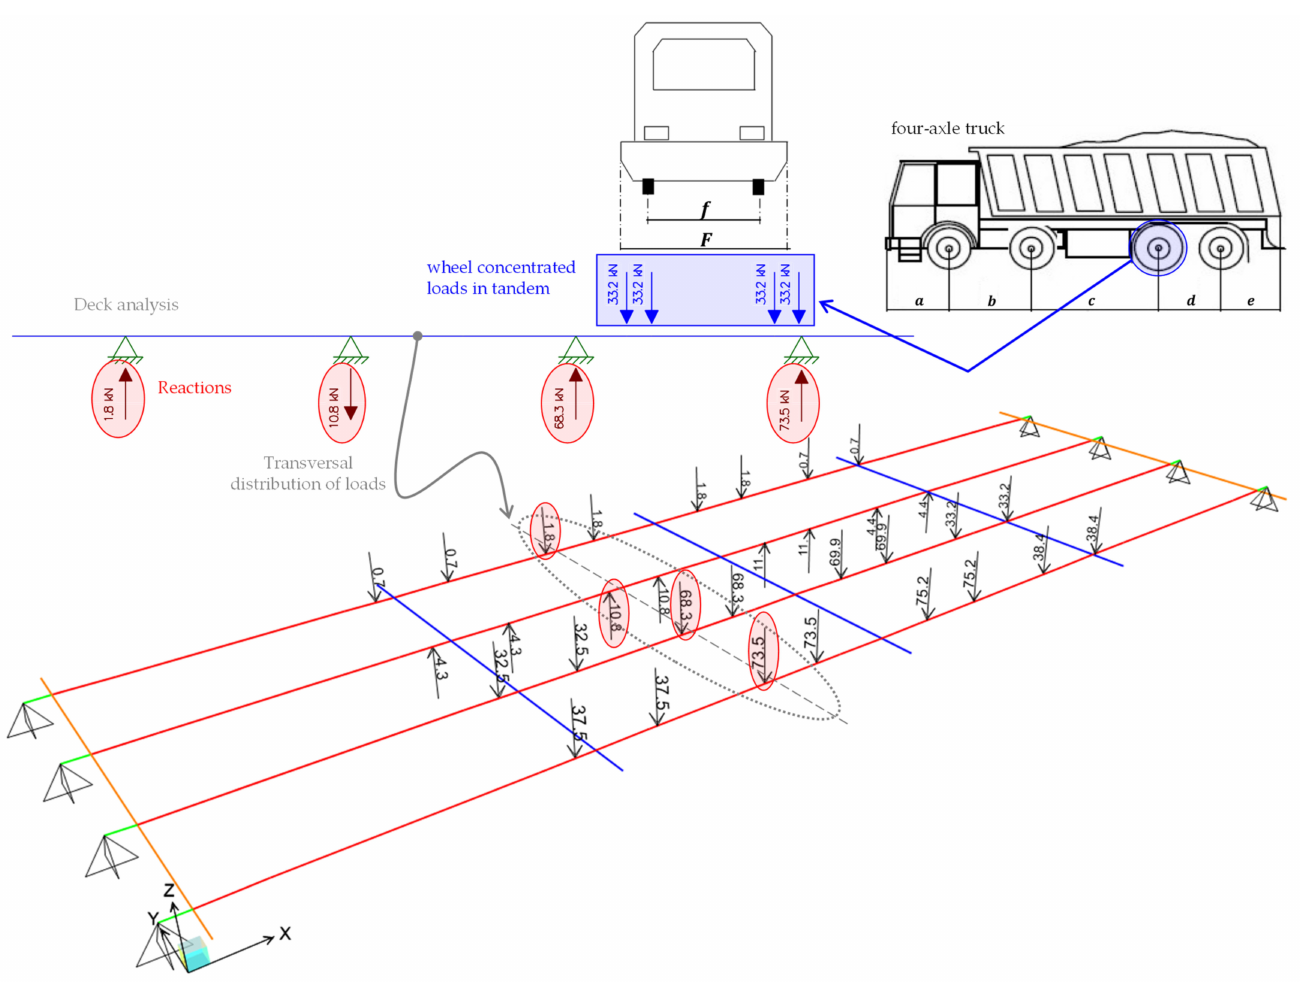
Figure 16. Simplified calculation of load distribution in FE model, representative example simulating loading phase